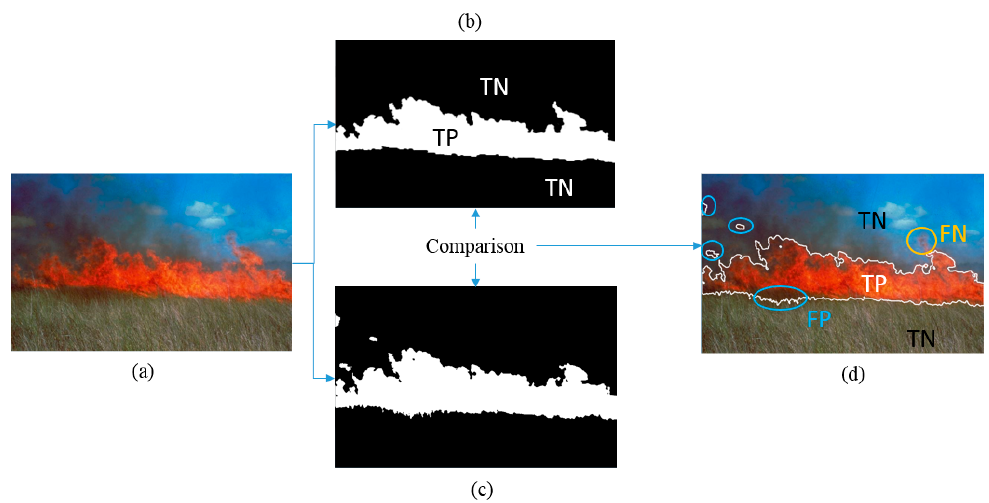
Figure 5. Illustration of classification of the resulting segmented regions. In ( a ) original image; ( b ) ground truth; ( c ) detection by FFDI; ( d ) comparison result.